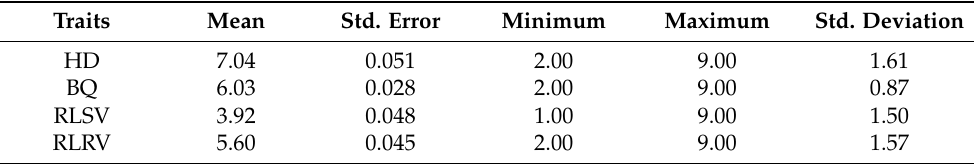
Table 1. Descriptive statistics of feet and leg conformation traits